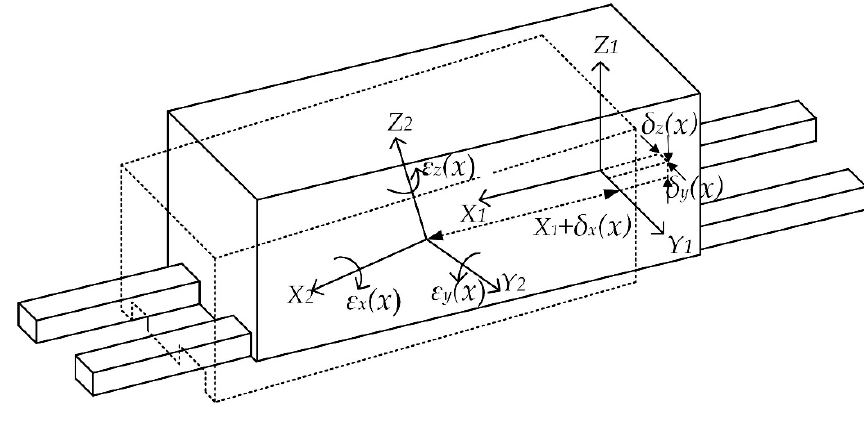
Figure 1. The six geometric errors of the X axis.